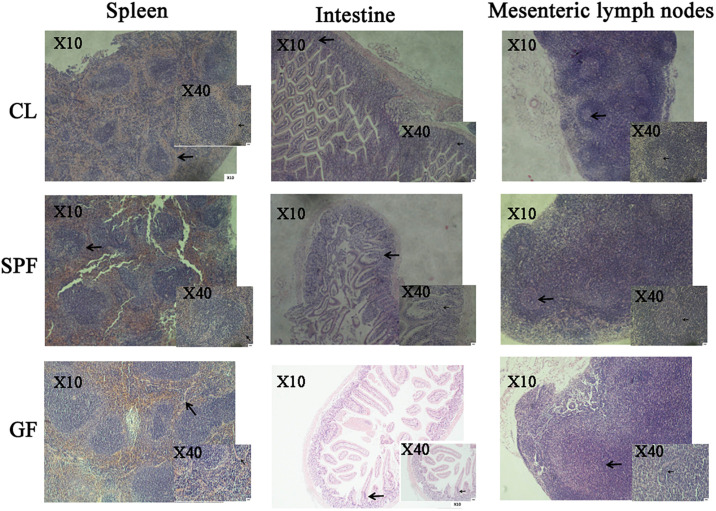
The morphology of spleen, intestine, mesenteric lymph node in different classes of BALB/c mice by H&E staining. The arrow in the spleen picture indicates the peripheral edge of the white pulp in the spleen. The arrow in the intestine picture indicates the central villi of the small intestine. The arrow in the mesenteric lymph node image indicates the lymph node. GF, Germ-free class mice; SPF, Specific Pathogen-free mice; CL, Clean Class mice.